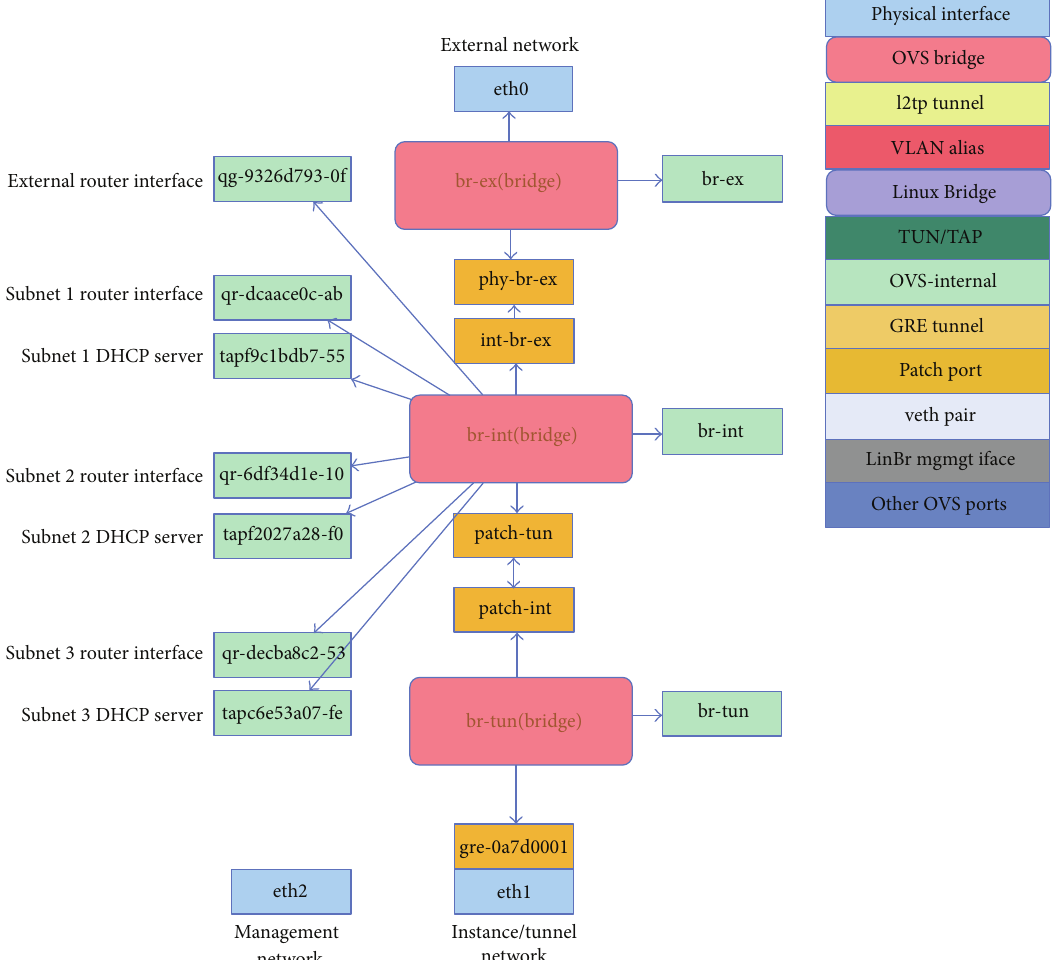
Figure 2: Network elements in an OpenStack network node connected to three virtual subnets. Three OVS bridges (red boxes) are interconnected by patch port pairs (orange boxes). br-ex is directly attached to the external network physical interface ( eth0 ), whereas GRE tunnel is established on the instance/tunnel network physical interface ( eth1 ) to connect br-tun with its counterpart in the compute node. A number of br-int ports (light-green boxes) are connected to four virtual router interfaces and three DHCP servers. An additional physical interface ( eth2 ) connects the network node to the management